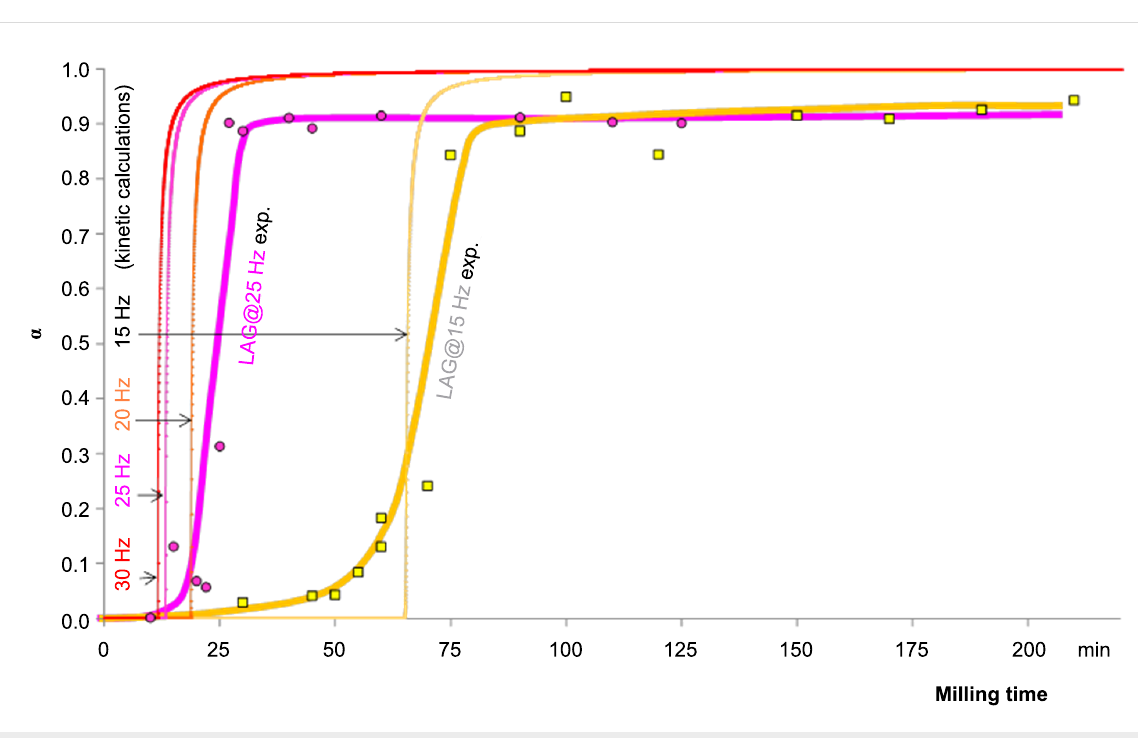
Figure 4: Reaction profiles for LAG mechanochemical milling according to Equation 4. The modelled curves are given for each milling frequency, and experimental data points are provided for 25 Hz (pink circles) and 15 Hz (yellow squares). No fitting was performed for the experimental data and the kinetic curves drawn are only a guide to the eye. E 0 : τ =